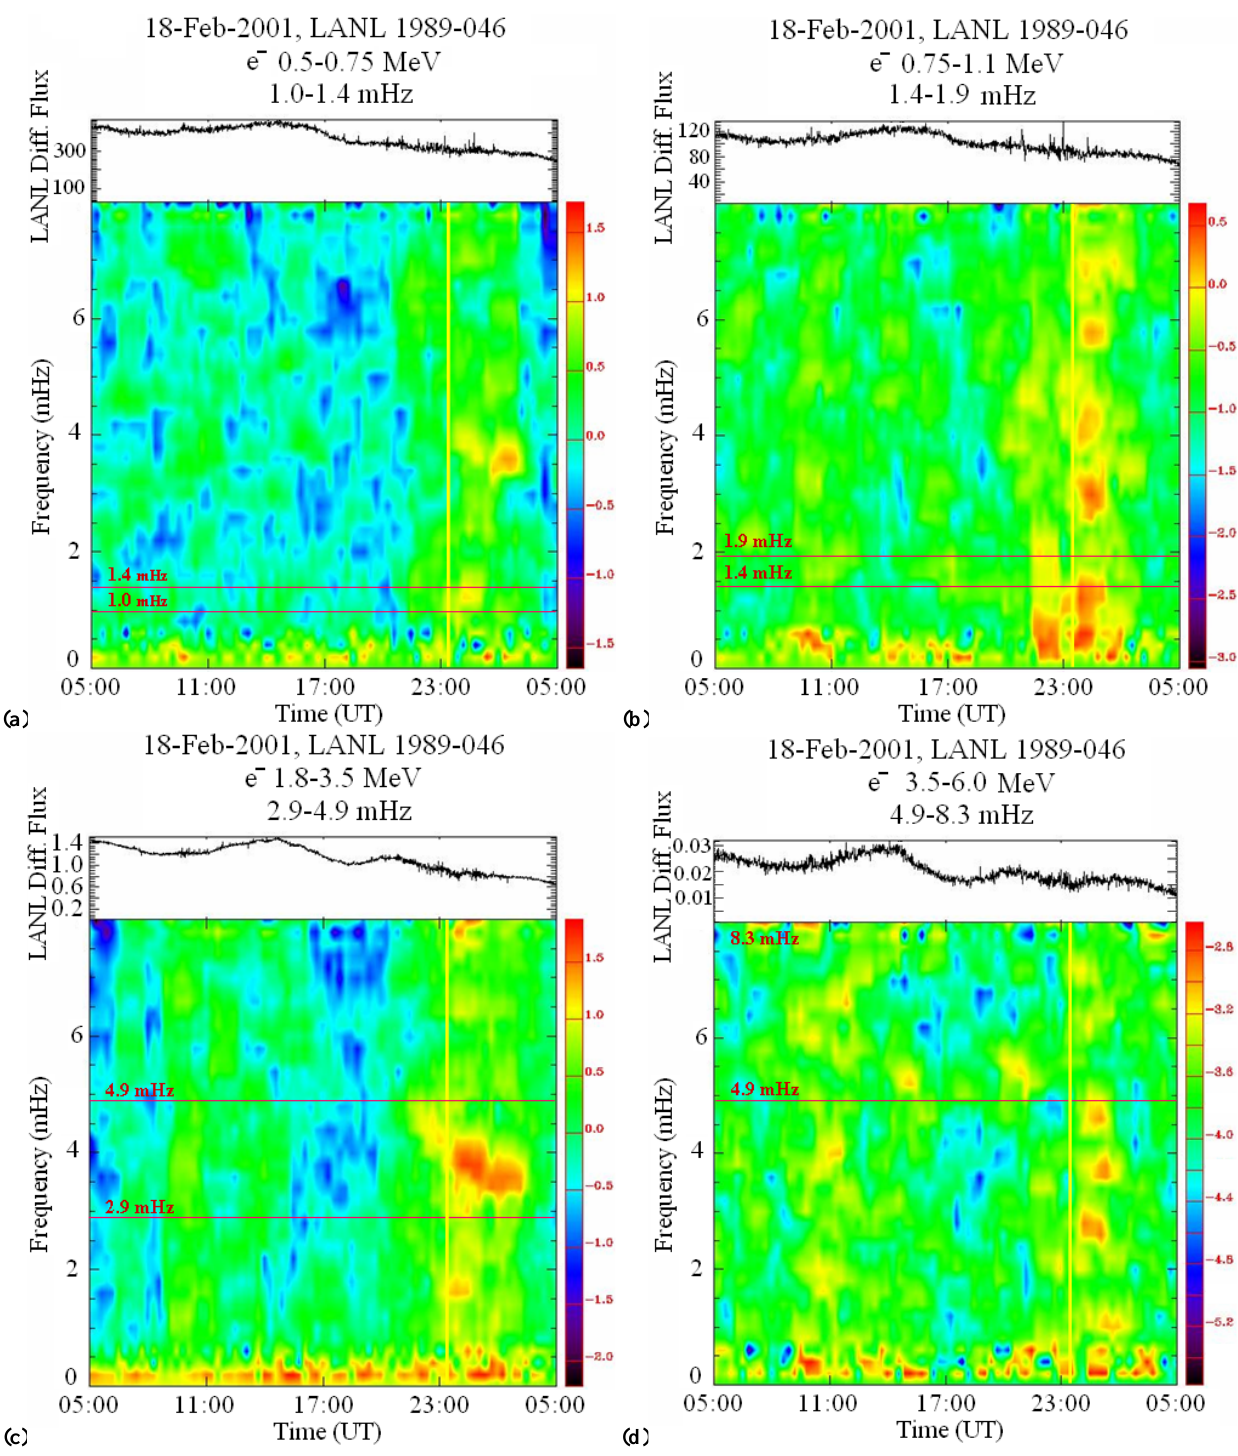
Fig. 6. Dynamic Spectra of the flux modulation of electrons measured by the SOPA instrument onboard LANL 1989-046 geosynchronous satellite on 18 February 2001 from four different energy channels. Distinct flux modulation is observed around the local time of the narrow- band magnetic field fluctuations. The red lines on these plots mark the drift-frequencies of electrons at the lower and upper ends of each energy channel and the yellow line marks the time when the spacecraft crosses local